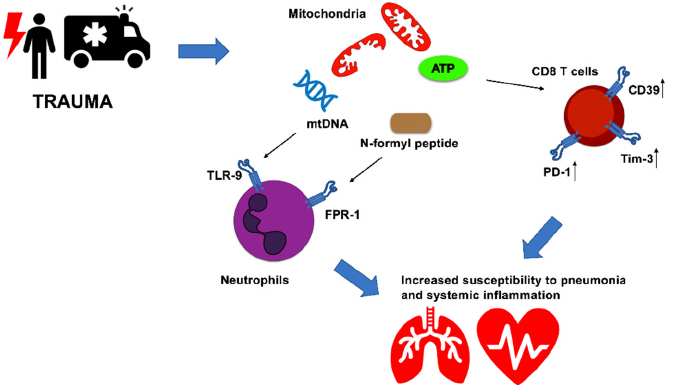
Figure 1. Mitochondria modulate innate and adaptive immune responses and impact clinical course of critically ill patients. Trauma-induced injury elicit rapid immune responses mediated by released mitochondria after cellular damage. Circulating mtDNA and mitochondrial derived N -formyl peptides are sensed by TLR9 and FPR1. ATP-producing mitochondria boost CD39, PD-1 and Tim-3 levels in CD8 T cells, favoring immune exhaustion. These immunological changes might increase the susceptibility to secondary infection and systemic inflammation in critically ill patients after traumatic insult.